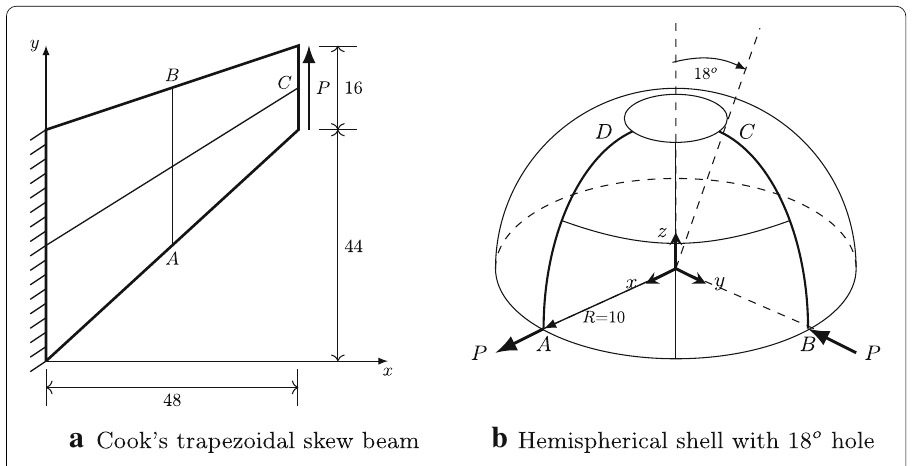
a b Fig. 2 Benchmark problems (with representative mesh density N = 2)